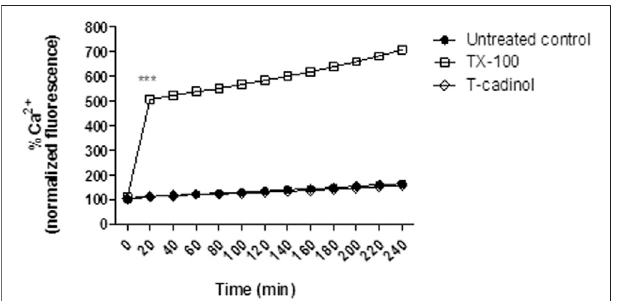
FIGURE 7 | - Evaluation of intracellular Ca 2+ levels in T. cruzi trypomastigotes treated with compound 1 (T-cadinol − 18.2 μ M) for 4 h. Fluo- 4 AM dye fl uorescence was monitored spectro fl uorimetrically (excitation 485 nm and emission 535 nm). Untreated trypomastigotes and those treated with 0.5% TX-100 were used as negative and positive controls, respectively.Fluorescenceisreportedasthepercentage relativetotime0 min (100%). *** p <